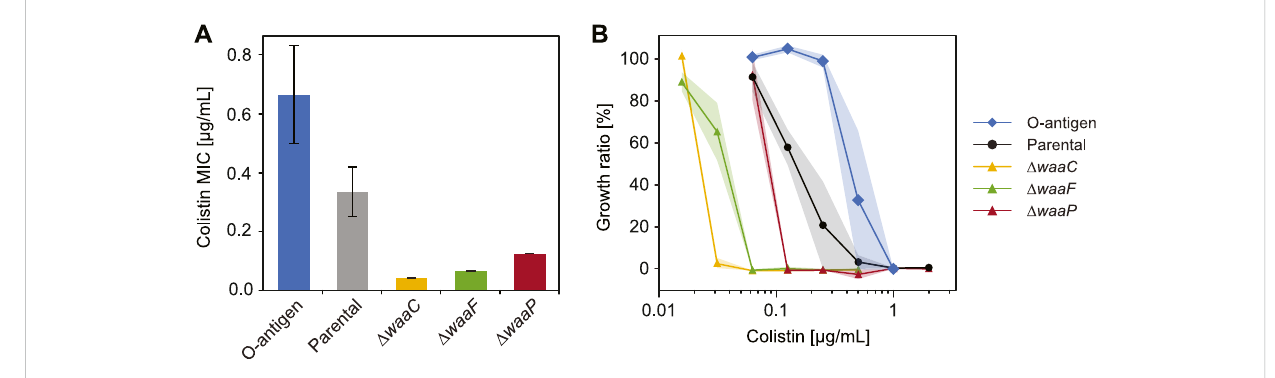
FIGURE 4 Variationsin E.coli LPSstructures affectbacterialresponsetocolistin. (A) Minimum inhibitoryconcentration(MIC)ofcolistintestedfor E.coli strains expressing different LPS structures ( n = 3, error bars indicate standard error). (B) Growth inhibition of E. coli O-antigen expressing strain (diamonds), parental strain (circles), and mutants with truncated core oligosaccharide (triangles) exposed to varying colistin concentrations. Shaded areas indicate standard errors of three